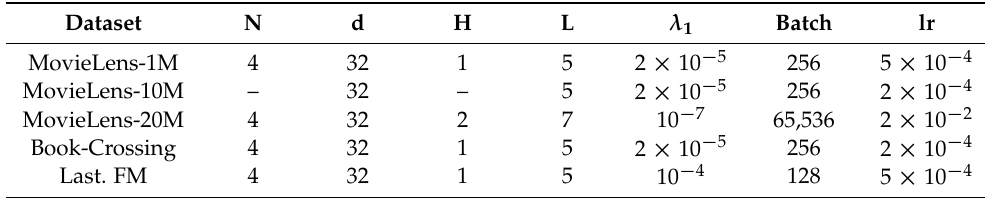
Table 2. Experimental parameter setting.